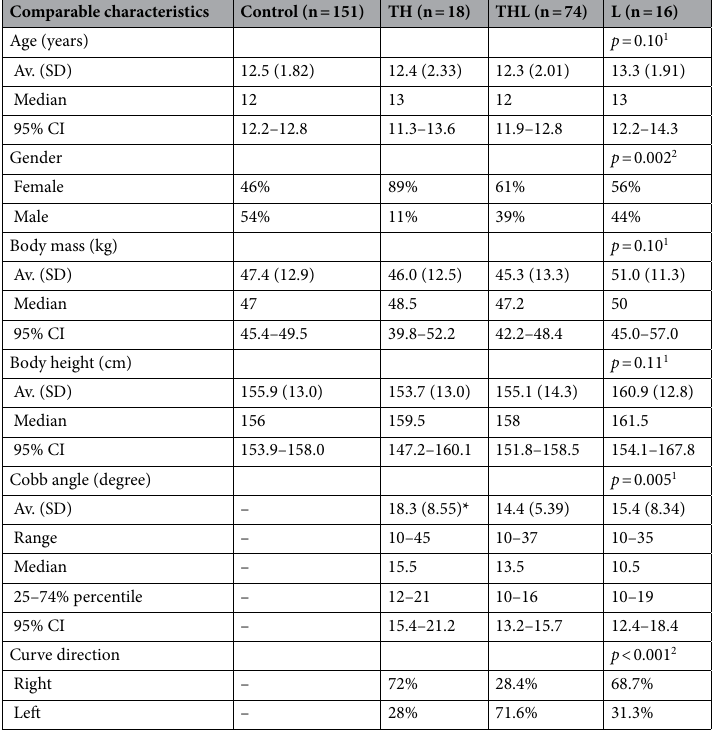
Table 1. General characteristics of patients without scoliosis (Control) and thoracic (Th), thoracolumbar (THL) and lumbar (L) scoliosis. 1 One-way ANOVA. 2 Chi-squared test. *Significant difference compared to THL in planned